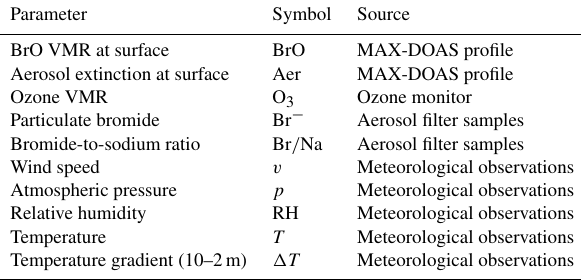
Table 4. Surface parameters included in the regression analysis.